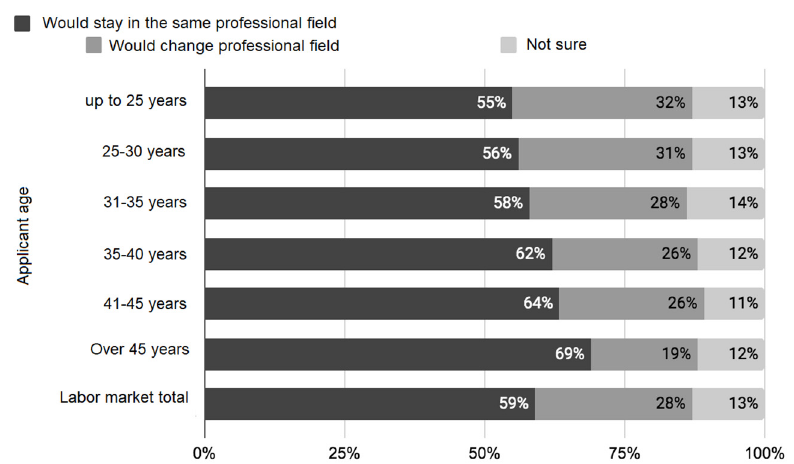
Figure 1. Answer of applicants to the question “If everyone was paid the same high salary, you would …” (Compiled by the authors based on materials of Almanac HeadHunter (2017)).